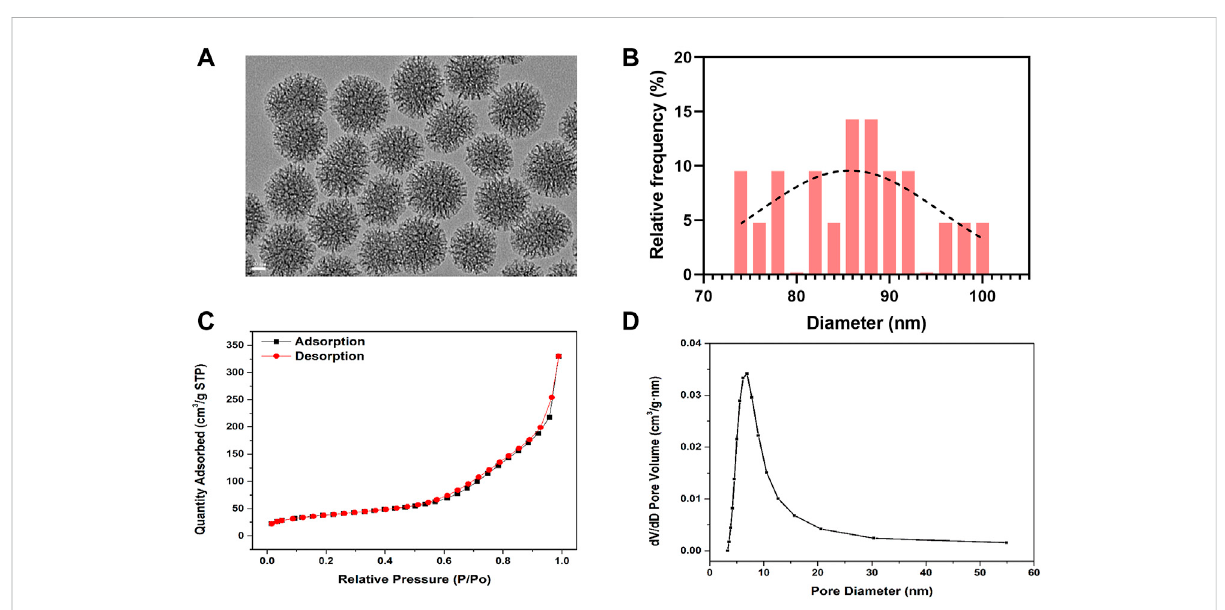
FIGURE 1 Characterization of mesoporous bioactive glass nanoparticles (BG NPs). (A) TEM images. Scale = 20 nm. (B) Particle-size analysis by ImageJ of mesoporous BG NPs. (C) Nitrogen adsorption – desorption isotherms and (D) Pore-size distribution of BG